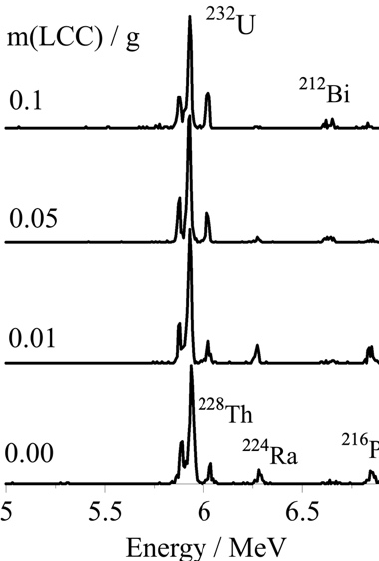
Figure 3. The alpha spectra of the U ‐ 232 ‐ traced aqueous solutions after treatment with different masses of unmodified (m(LCC) in g) and oxidized biochar (m(LCC_ox) in g). [U ‐ 232] = 8.6 × 10 − 14 mol/L, pH 4 and ambient conditions. It has to be noted that Bi ‐ 212, Ra ‐ 224, Th ‐ 228 and Po ‐ 216 are daughter nuclides of U ‐ 232 and are therefore present in the alpha spectra.